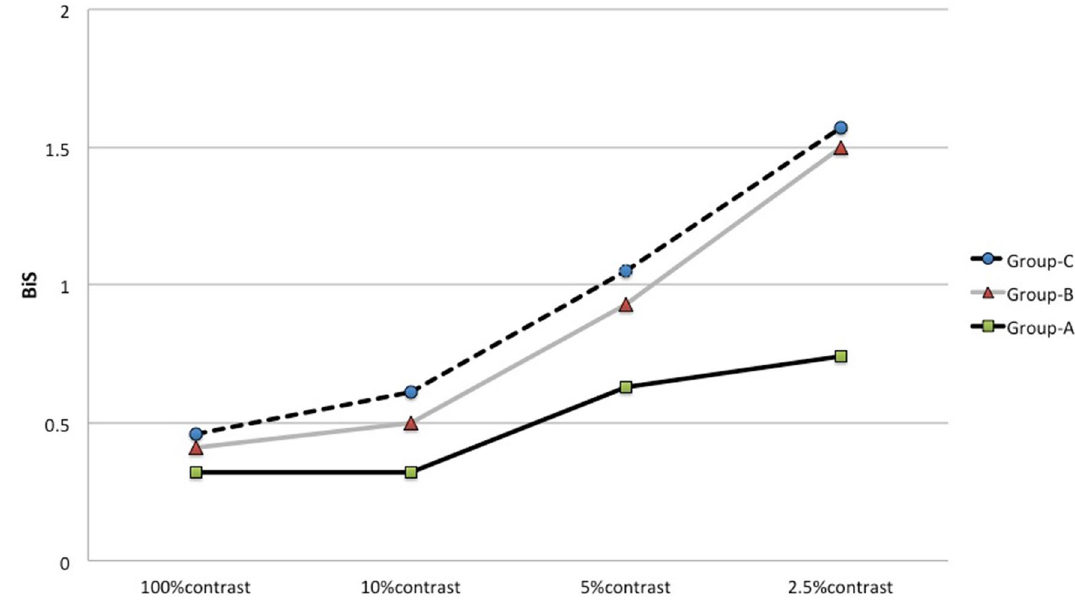
Figure 1. The average BiS records at different contrasts in three groups based on distant RDS after surgery. 100% contrast visual acuity